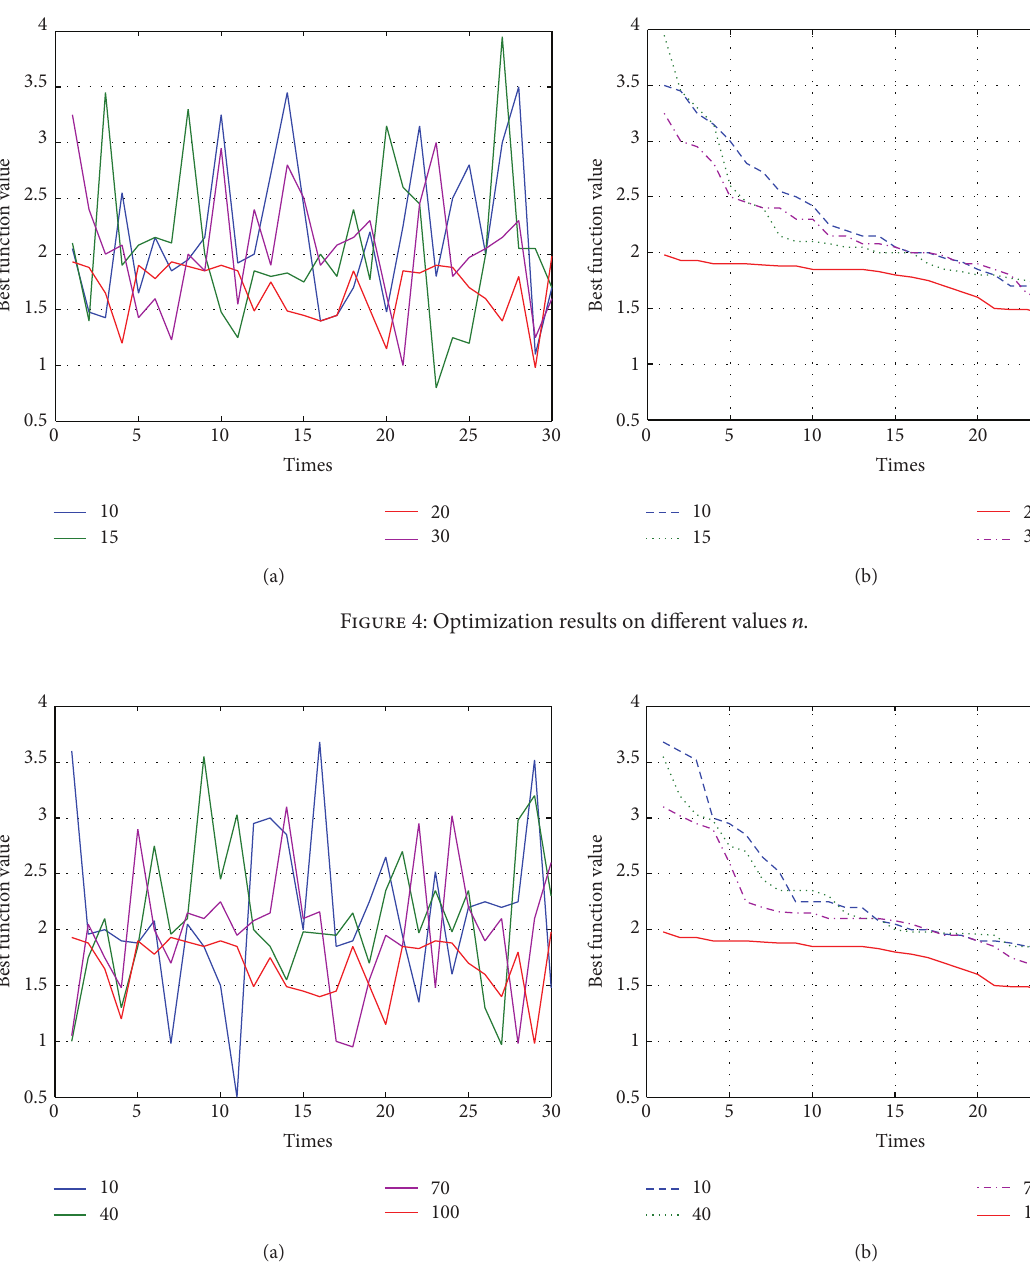
Figure 5: Optimization results on different values 𝑇 .